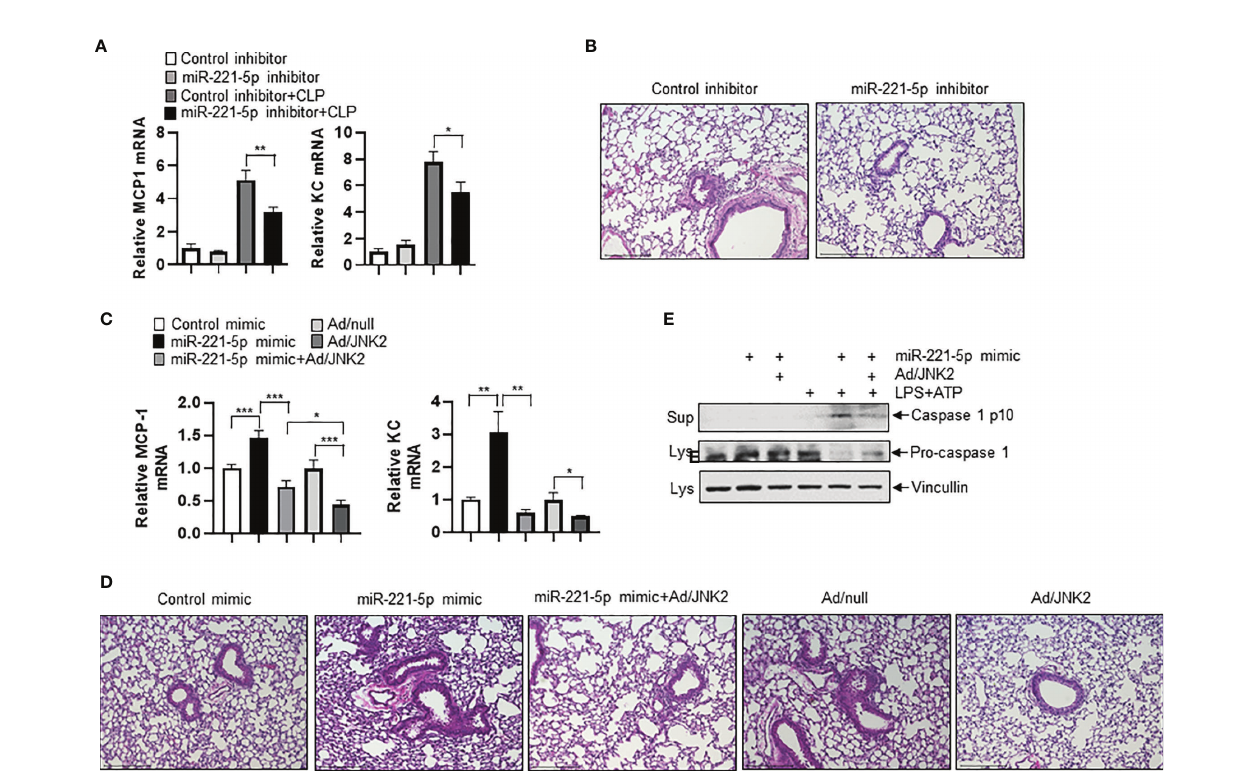
FIGURE 8 | miR-221-5p exacerbates sepsis-induced lung in fl ammation and injury by targeting JNK2 mRNA. (A, B) mRNA levels of MCP-1 and KC in lung tissues (A) , or lung histology by H&E staining (B) from mice treated intratracheally with control inhibitor or miR-221-5p inhibitor, followed by sham or CLP treatment. N=4. (C, D) mRNA levels of MCP-1 and KC in lung tissues (C) , or lung histology by H&E staining (D) from mice treated intratracheally with control mimic, or miR-221-5p mimic, or miR-221-5p mimic with Ad/JNK2, or Ad/null, or Ad/JNK2, followed by CLP treatment. N=3-5. (E) Western blot of Caspase 1 p10 in the supernatant and Pro-caspase 1 in the cell lysates of RAW 264.7 cells transfected with control mimic or miR-221-5p mimic in the absence or presence of Ad/JNK2 infection, followed by treatment with LPS (10 ng/ml) for 16 h and then ATP (2mM) for 1 h. Data are presented as means ± sem. * p < 0.05; ** p < 0.01; *** p <